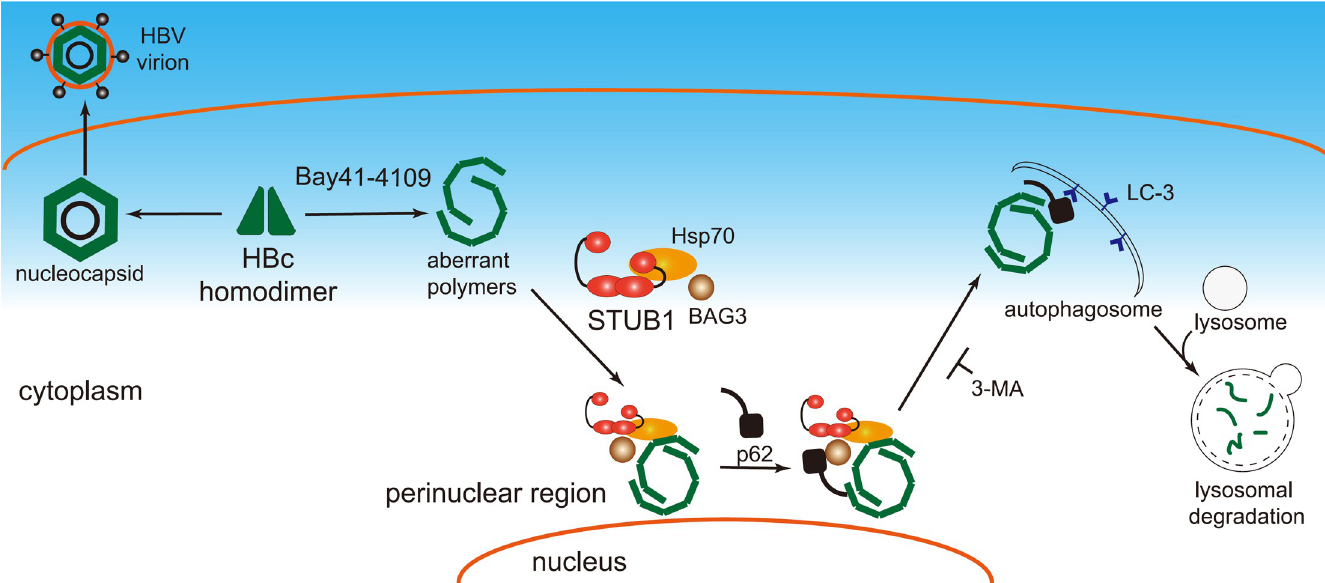
Fig 10. Working model. HAP-induced aberrant non-capsid polymers form complexes with STUB1, Hsp70 and BAG3, and are transported to the perinuclear compartment. Subsequently, macroautophagy receptor p62 binds to the complexes (via interaction with BAG3) and directs aberrant non-capsid polymers to form macroautophagosomes, which are ultimately fused with